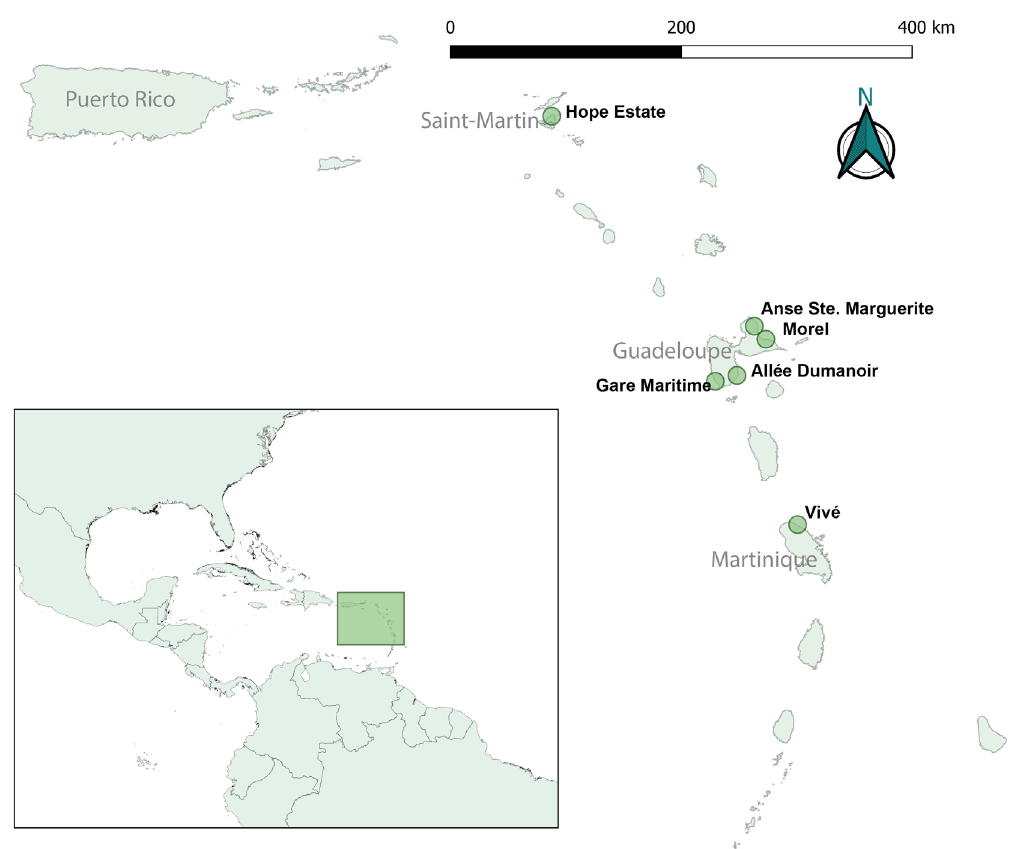
Figure 1: Map showing the location of the archaeological sites from which the beads were